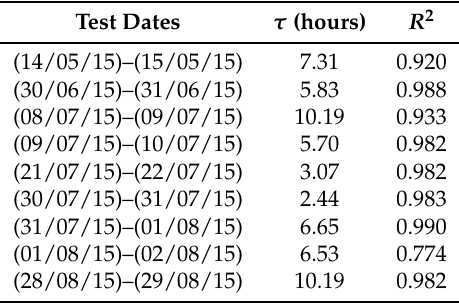
Table 1. Fitting results showing the RC Time Constant and the Coefficient of Determination for each